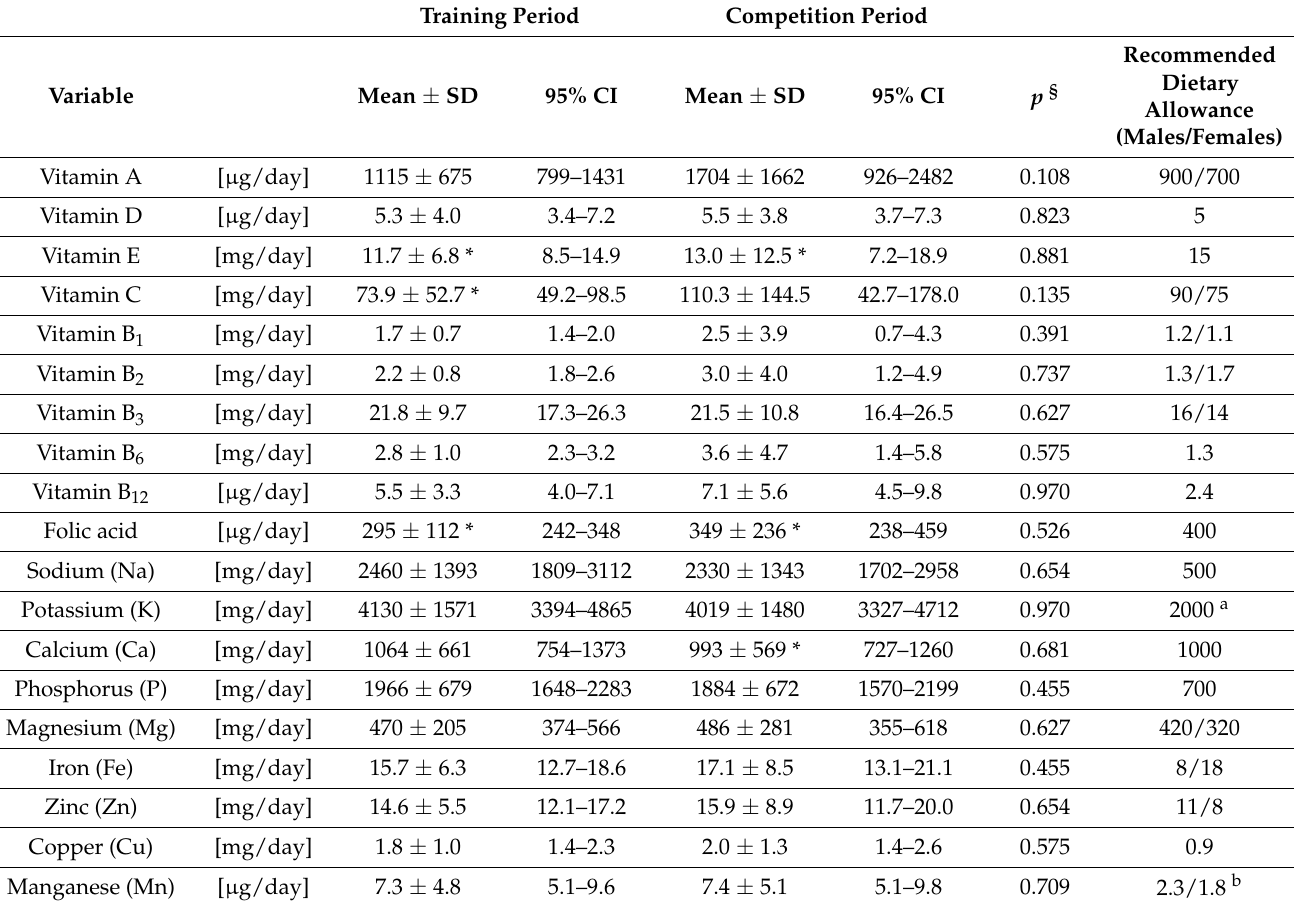
Table 4. Vitamins and minerals intake in the diet of triathletes during the training and competition period.